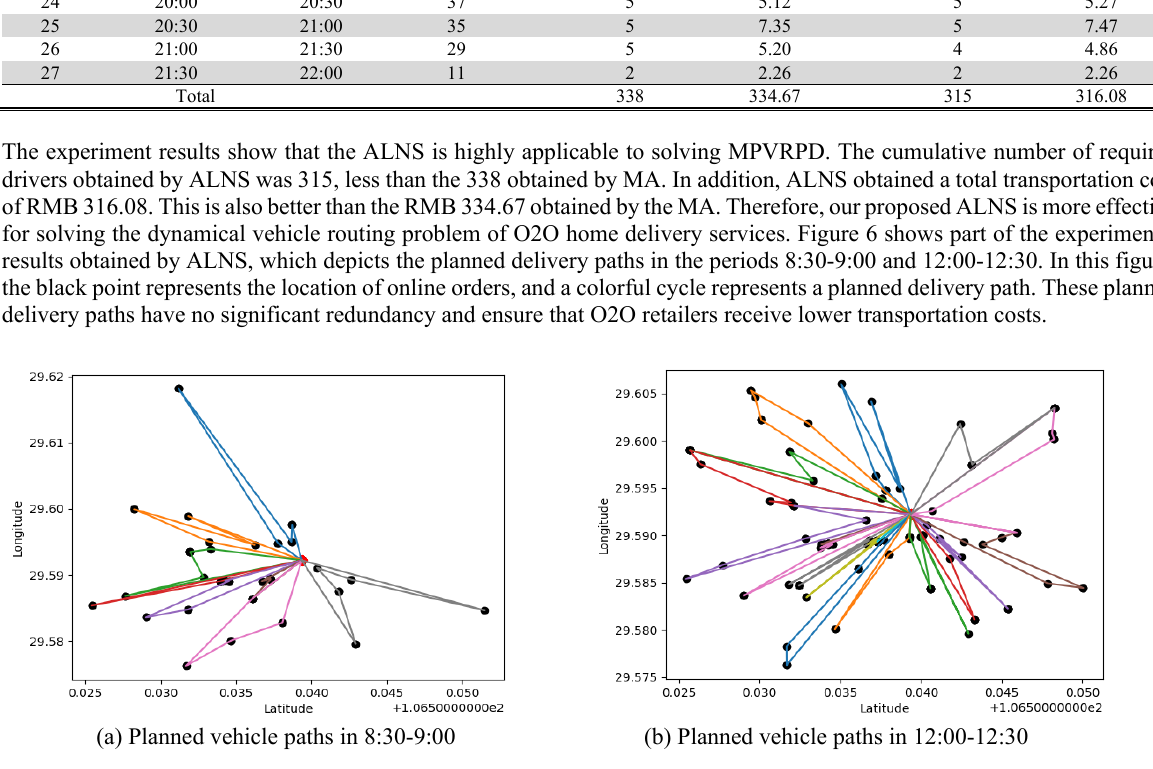
Fig. 6. Planned delivery paths in partial time intervals